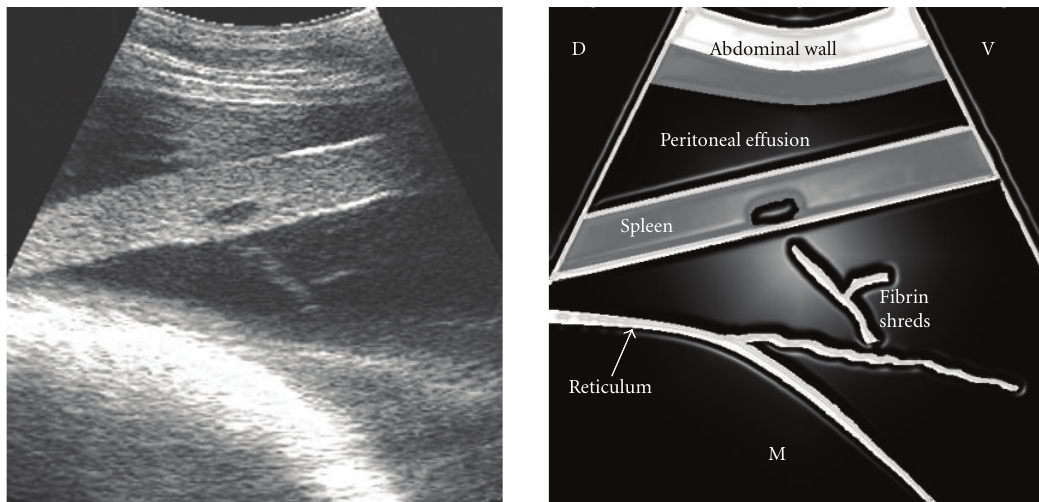
Figure 12: Ultrasonogram of the reticulum and spleen showing peritoneal e ff usion along with fibrin shreds viewed from the left 7th ICS. Notice the peritoneal e ff usion induced acoustic enhancement, depicted by the hyperechogenicity of the reticular wall. ICS: intercostal space; D: dorsal; V: ventral; M: